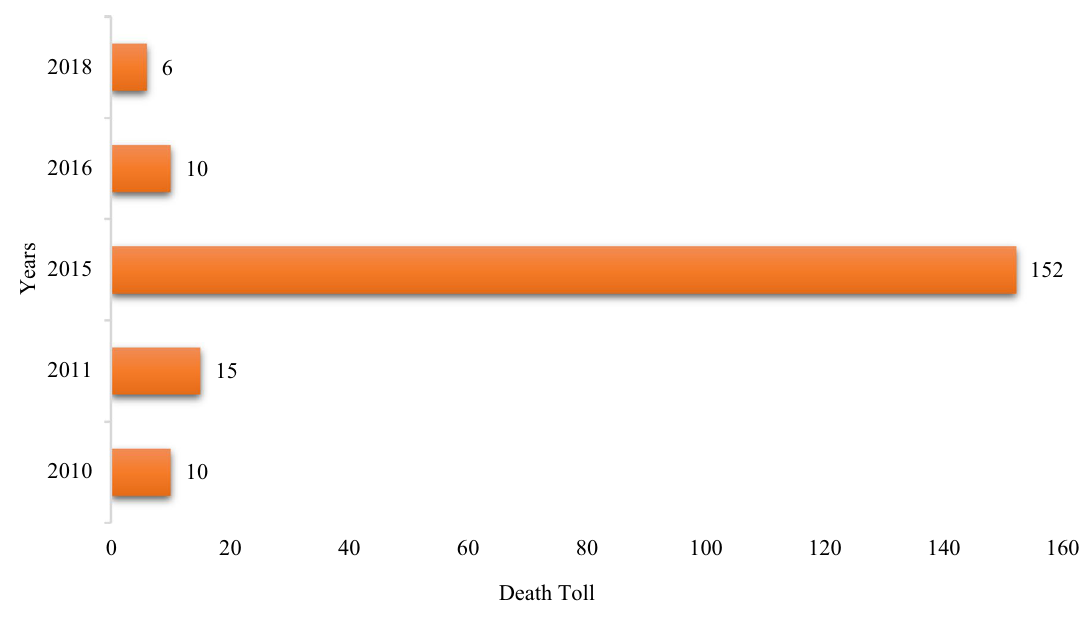
Fig. 7 Death Tolls (Okyere et al. 2013; Amoako and Boamah 2014; Asumadu-Sakodie et al. 2015a, b; Tabiri 2015; Kwang and Matthew Osei 2017)